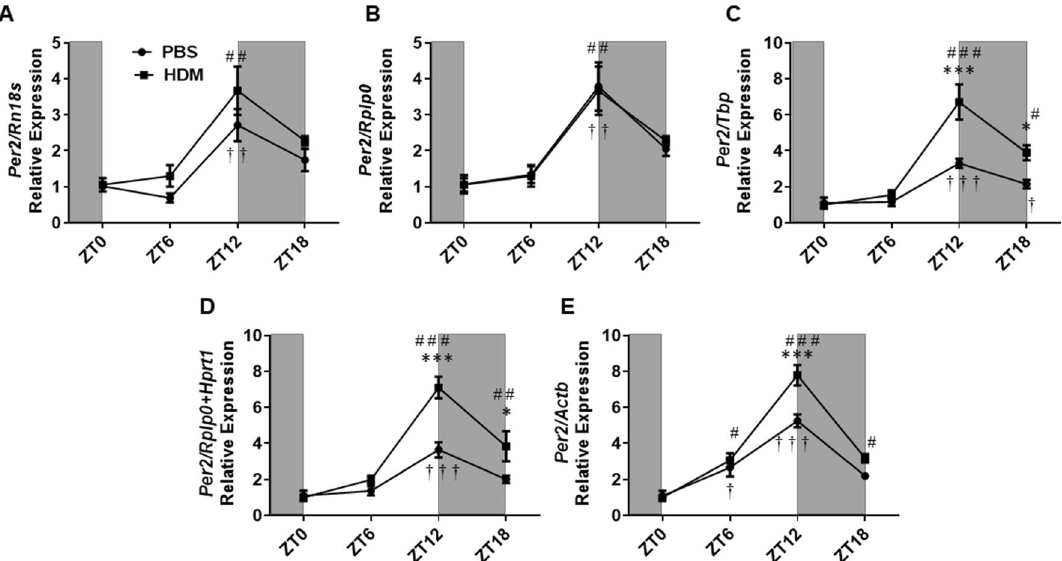
Figure 7. Per2 gene relative expression in HDM and PBS exposed mouse lungs and data normalized with different reference genes. ( A ) Rn18s , ( B ) Rplp0 , ( C ) Tbp , ( D ) Rplp0 + Hprt1, and ( E ) Actb . Line graphs showing the relative expression of Per2 gene in both HDM versus PBS group. White and gray areas in the graph represents the light and dark cycle, respectively. Symbols † and # represent the statistical significance in temporal expression of Per2 in the PBS and HDM group respectively at the marked time point when compared to the baseline (ZT0). Data are shown as mean ± SEM (n = 4/group; * P < 0.05, *** P < 0.001 compared to respective control; † P < 0.05, †† P < 0.01, ††† P < 0.001, compared to ZT0 PBS; # P < 0.05, # # P < 0.01, # # # P < 0.001, compared to ZT0